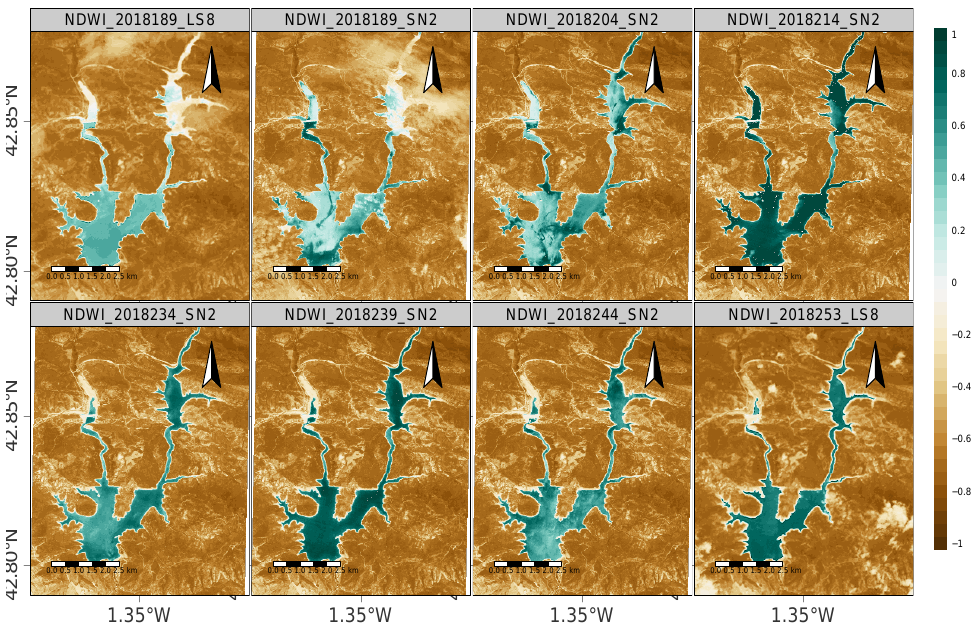
Figure 4. Water detection (blue color) at the Itoiz reservoir. The first eight instances of the NDWI time series from Landsat-8 (“LS8”) and Sentinel-2 (“SN2”). The “x” and “y” axes are the longitude and latitude coordinates. The names of the panels additionally show the capturing date of the image in YYYYJJJ format, where Y and J represent a year and a Julian date digit, respectively. Estimates represented well the variations of the water levels measured in situ. The MAE showed a good agreement between the ground truth data and the estimates (0.66 m) for both satellites